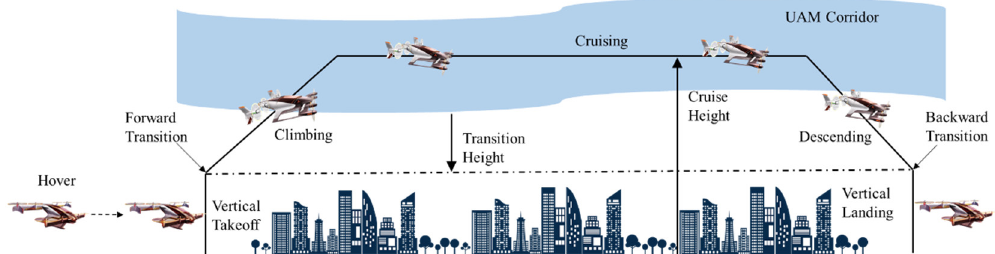
Figure 1. Typical mission profile for VTOL aircraft.